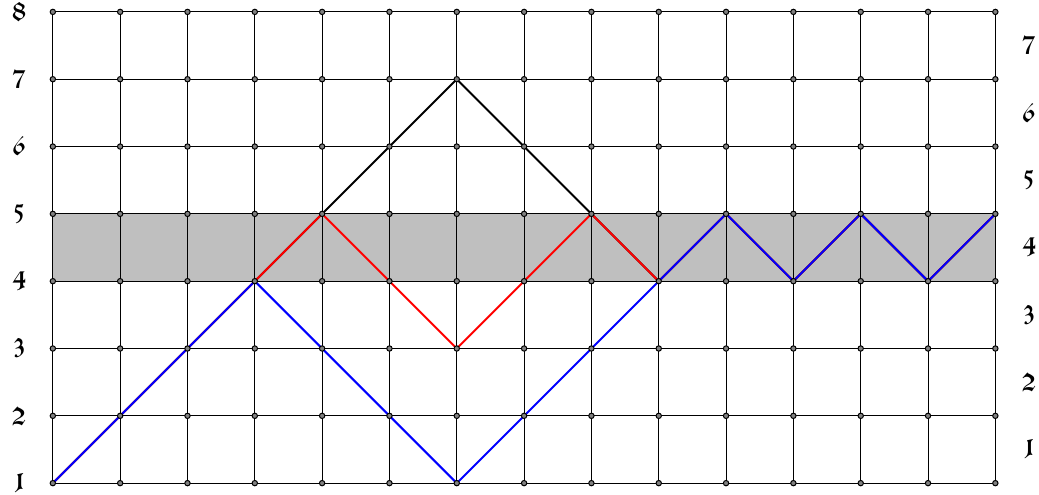
Figure 13 . Three paths with single peak/valley in the restricted solid-on-solid model L 2 ; 9 respec- tively shown in black, red and blue colors.